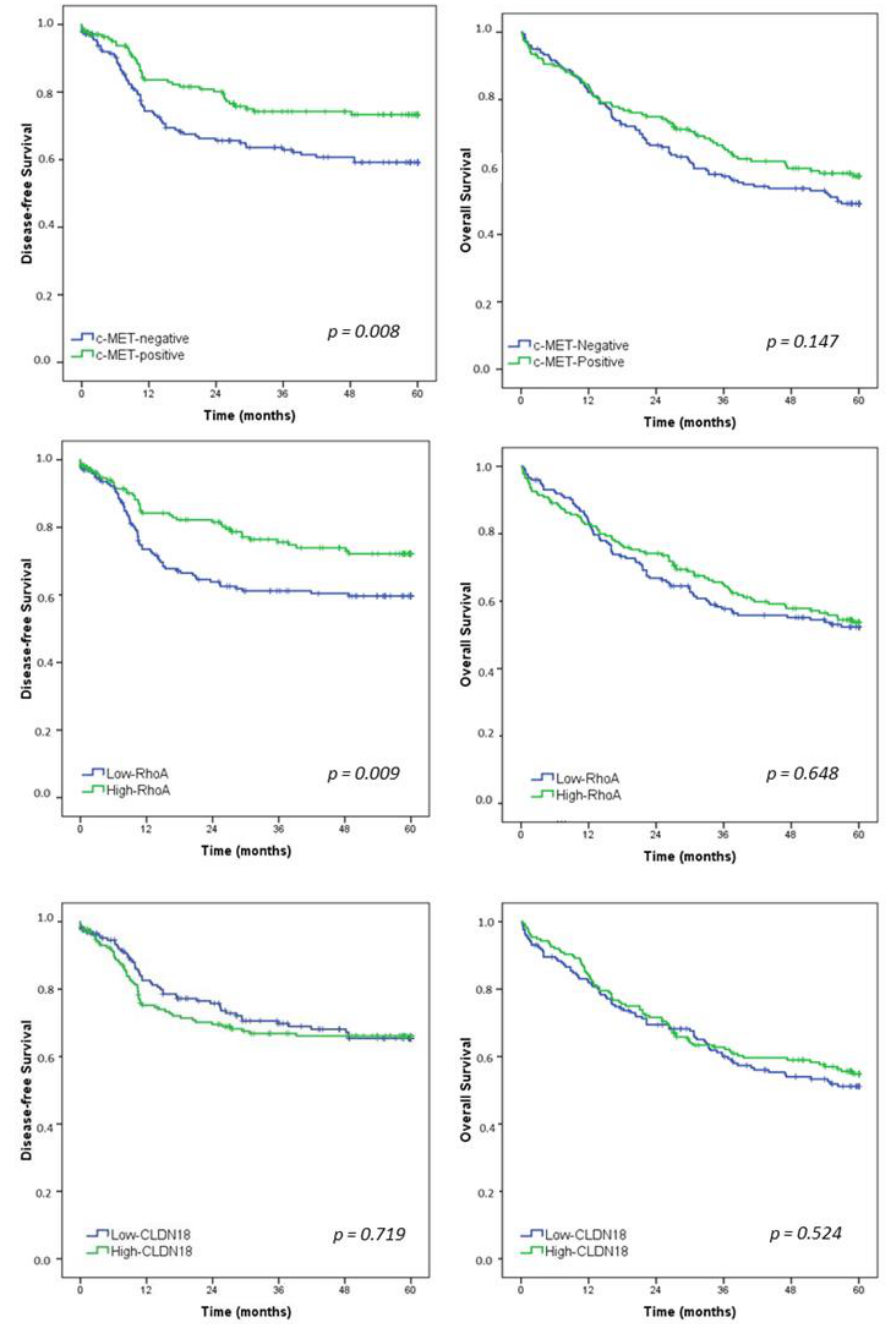
Figure 3. Kaplan–Meier survival analysis. Disease-free survival and overall survival in gastric cancer patients according to c-MET, RhoA, and CLDN18—Low vs. High groups. DFS was worse for c-MET-negative GC compared to c-MET-positive group ( p = 0.008). Furthermore, low-RhoA patients had a significantly poor survival than patients with high-RhoA GC ( p = 0.009). For CLDN18, DFS was similar between the low and high- CLDN18 groups ( p = 0.719).